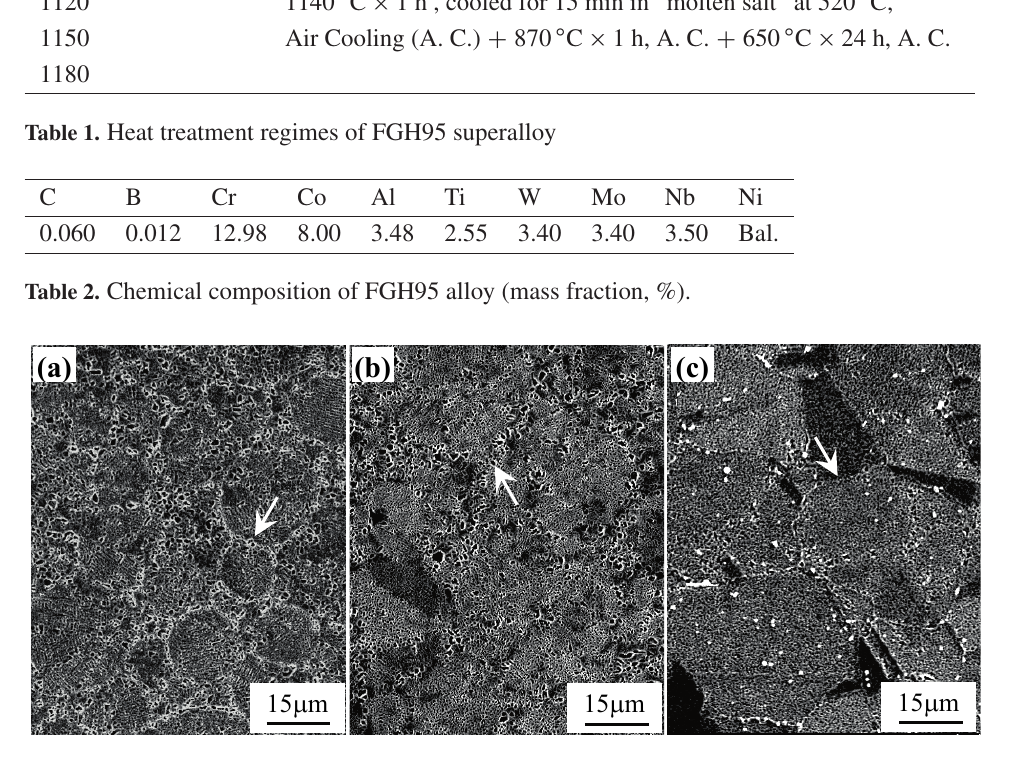
Figure 1. Microstructure of the alloy after HIP treated at different temperatures. (a) After the alloy was HIP treated at 1120 ı C, coarser (cid:2) 0 phase precipitate along the previous particle boundary (PPB) as marked with white arrow, (b) after HIP treated at 1150 ı C, the size and amount of primary (cid:2) 0 phase which distributed along PPB regions decreased slightly as marked with arrow, (c) after the alloy was treated at 1180 ı C, the grain boundary with straight feature was marked with